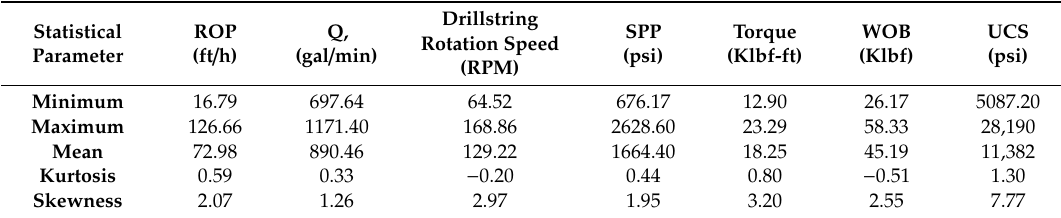
Table 3. Statistical parameters of the drilling parameters collected from the 16” intermediate section of Well